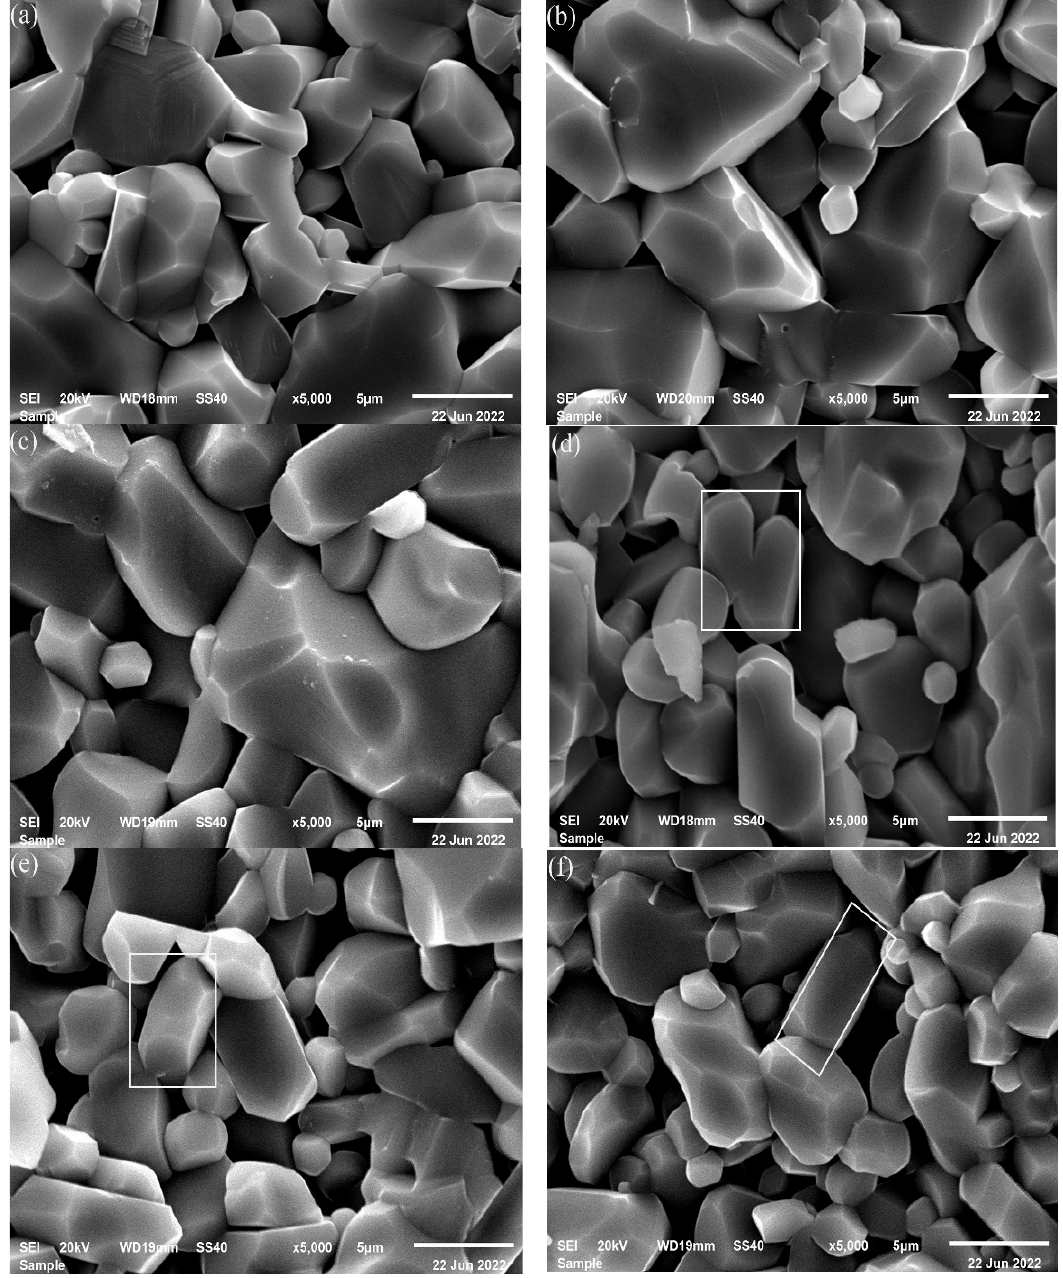
Figure 7. Fracture surfaces of Al 2 O 3 ceramics fabricated from various alumina powders: ( a ) VM 1 h; ( b ) VM 3 h; ( c ) VM 5 h; ( d ) DBDPM 1 h; ( e ) DBDPM 3 h; and ( f ) DBDPM 5 h.